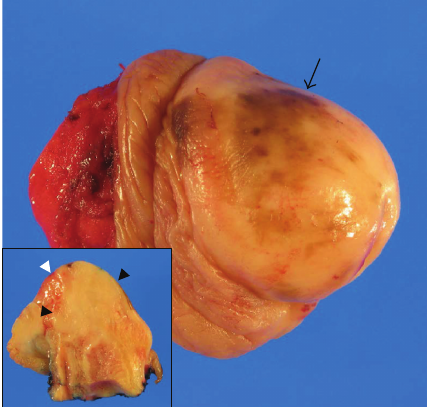
Figure 1: Glans of penis at penectomy. Gross examination shows scattered, flat, dark-brown discoloration mostly on the glans dorsal surface (black arrow) and ill-defined firmness of the entire glans. Cross sectioning (picture in picture) locates the firmness of glans to an indistinct, white, ulcer-free tumor measuring approximately 1.5 × 1.3cm on cut surface. The tumor (black arrowheads) has invaded into and through the urethra (white arrowheads: urethral opening and margin; single black arrow: tumor invasion).